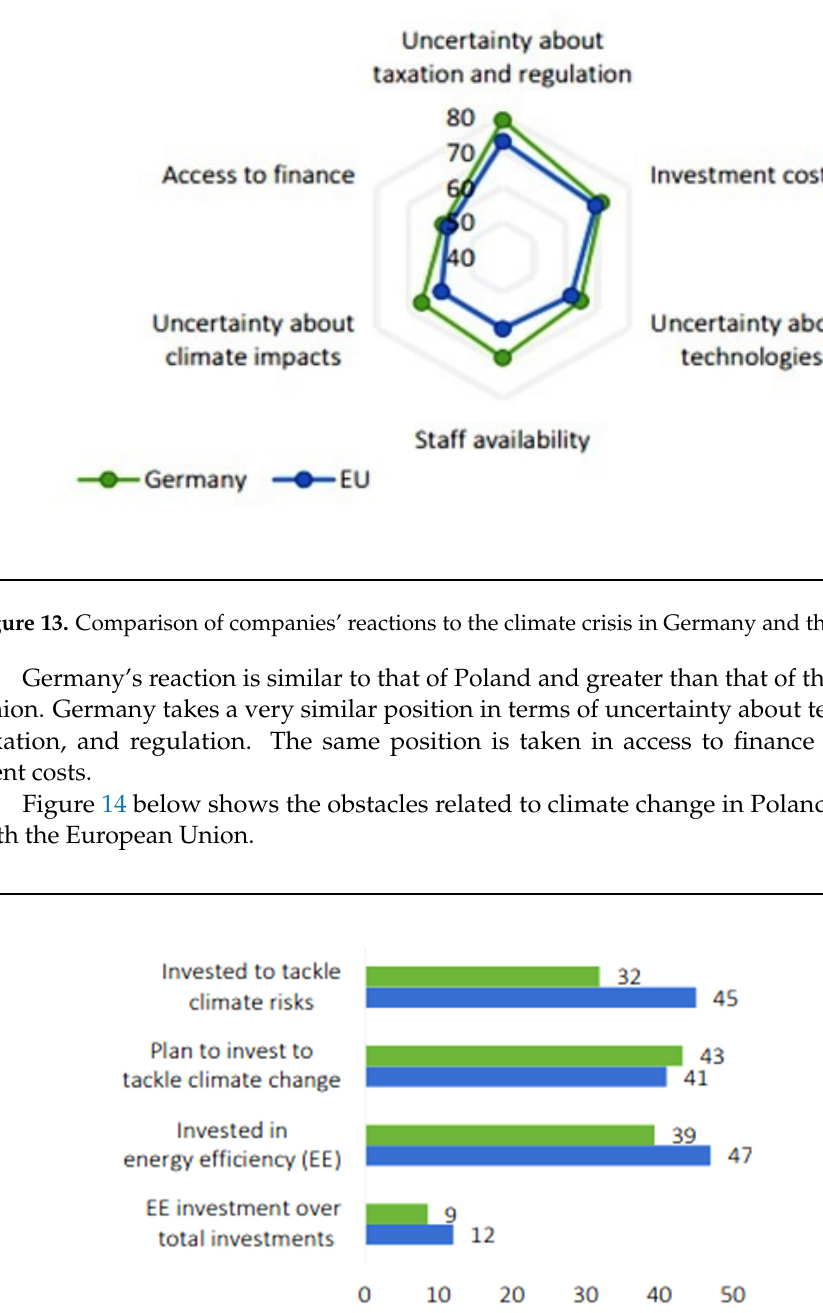
Figure 14. Obstacles for companies with climate change in Poland and the EU (%).